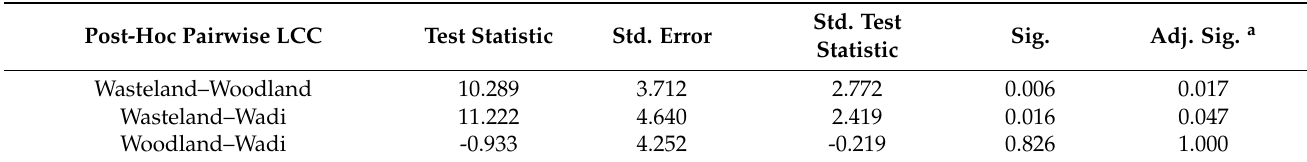
Table 6. Pairwise comparisons of